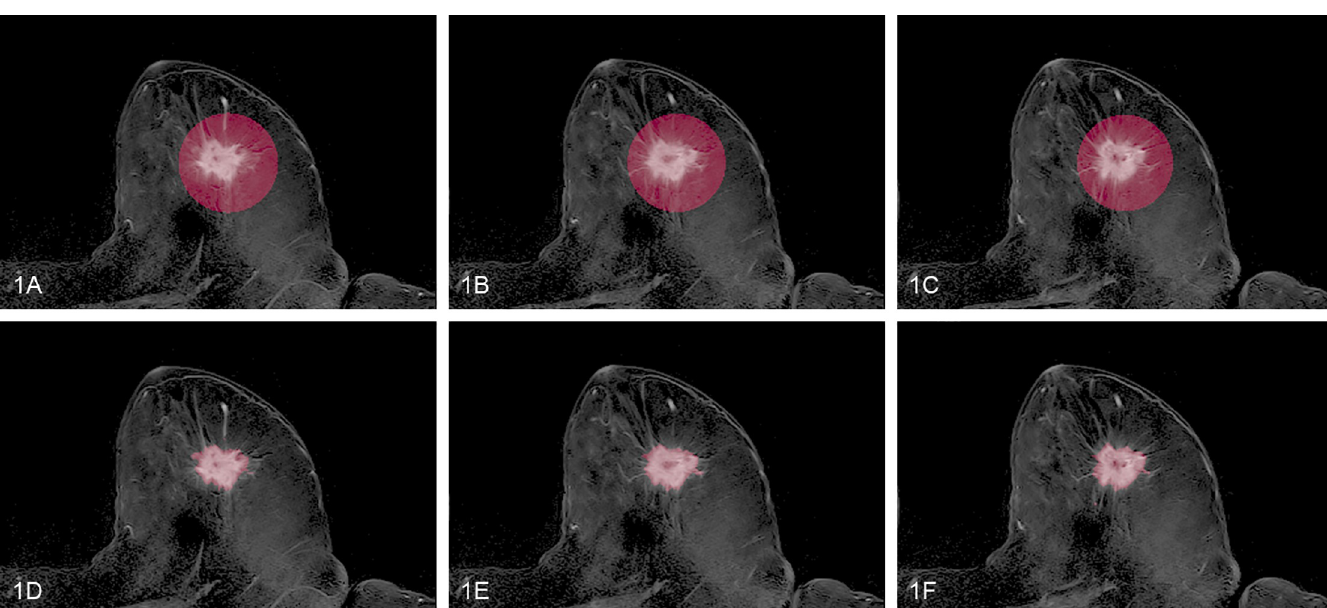
Fig 1. Imaging example of the VOI-encirclement of a tumor lesion. Fig 1A–1C display three consecutive axial slices of a tumor lesion in the second subtraction series annotated via VOI-encirclement. Fig 1D–1F show the corresponding semi-automatic fine tumor segmentation obtained by thresholding.